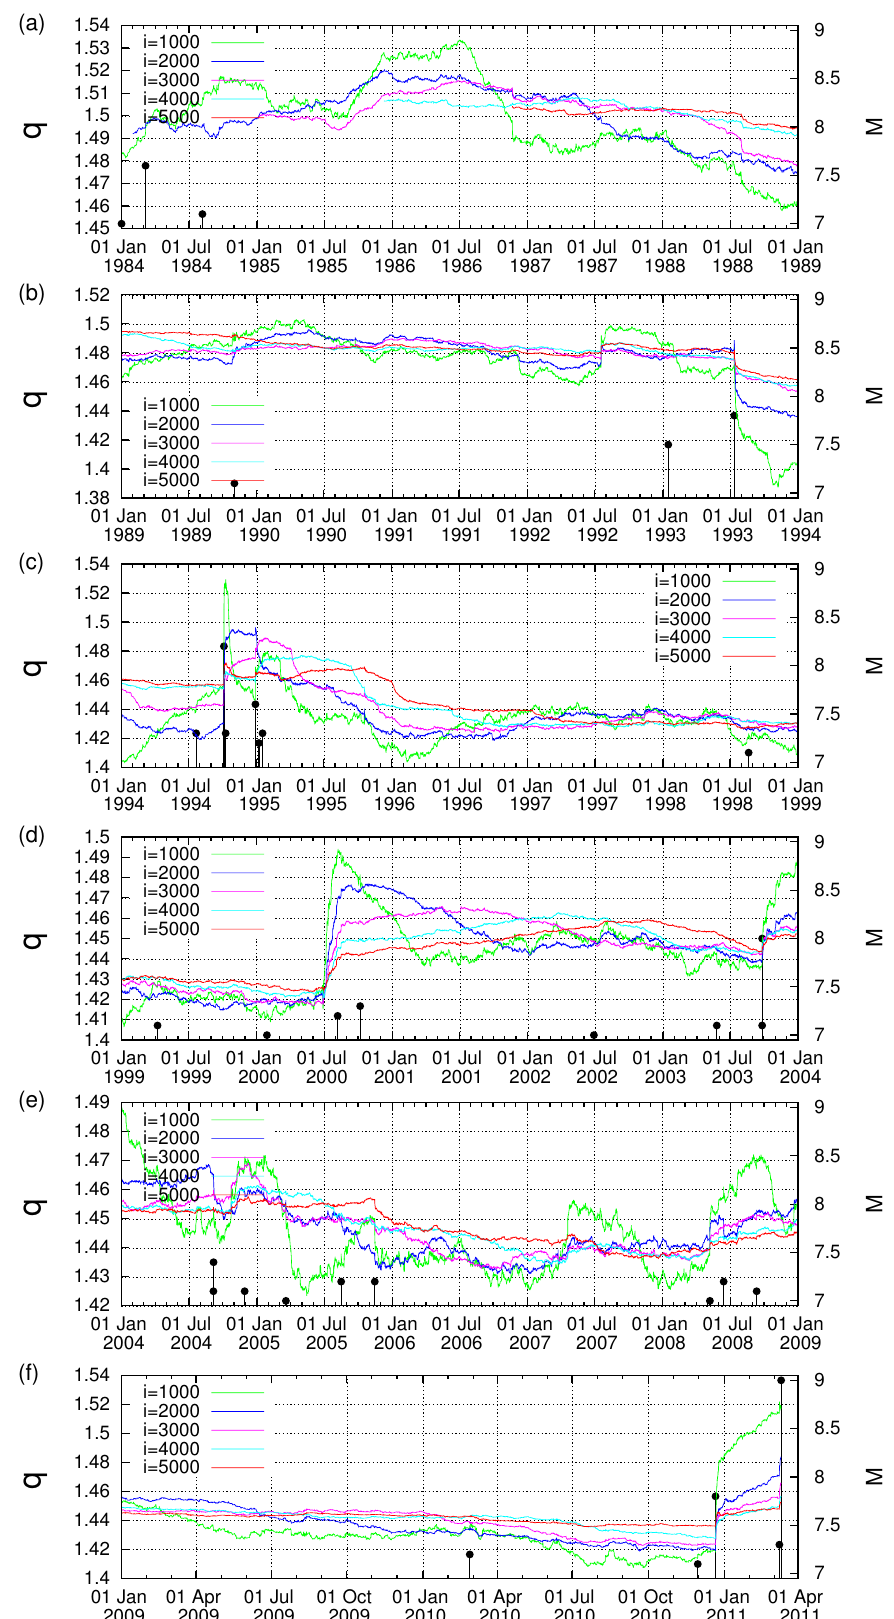
Figure 19. ( a – f ) Tsallis entropic index q values at the scales i = 1000, 2000, 3000, 4000 and 5000 events (colors in the inset) versus the conventional time. The vertical lines ending at black solid circles show the magnitudes ( M ≥ 7) of EQs, which are read in the right scale. Taken from Ref.